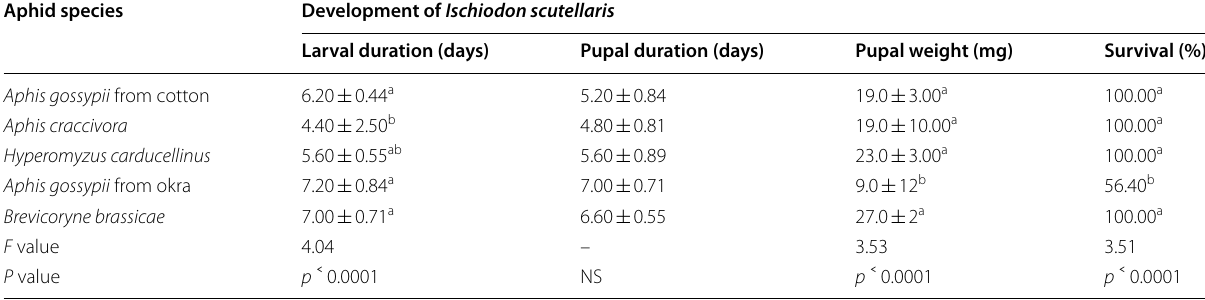
the pupal stage of I. scutellaris reared on different spe- cies of aphids. The pupal period of I. scutellaris ranged between 4.80 0.81 to 7.00 0.71 days across the differ- ± ± ent aphid hosts. There was a significant difference in the pupal weight of I. scutellaris reared on different species of aphids ( F value 3.53; df 5.45; P < 0.0001). The highest weight of = = pupae of I. scutellaris was recorded when the larvae were reared on B. brassicae (27 mg), which was statistically on par with that on H. carduellinus (23 mg), A. craccivora (19 mg) and A. gossypii (19 mg). The lowest weight of pupae of I. scutellaris (9 mg) was when reared on A. gos- sypii from okra.